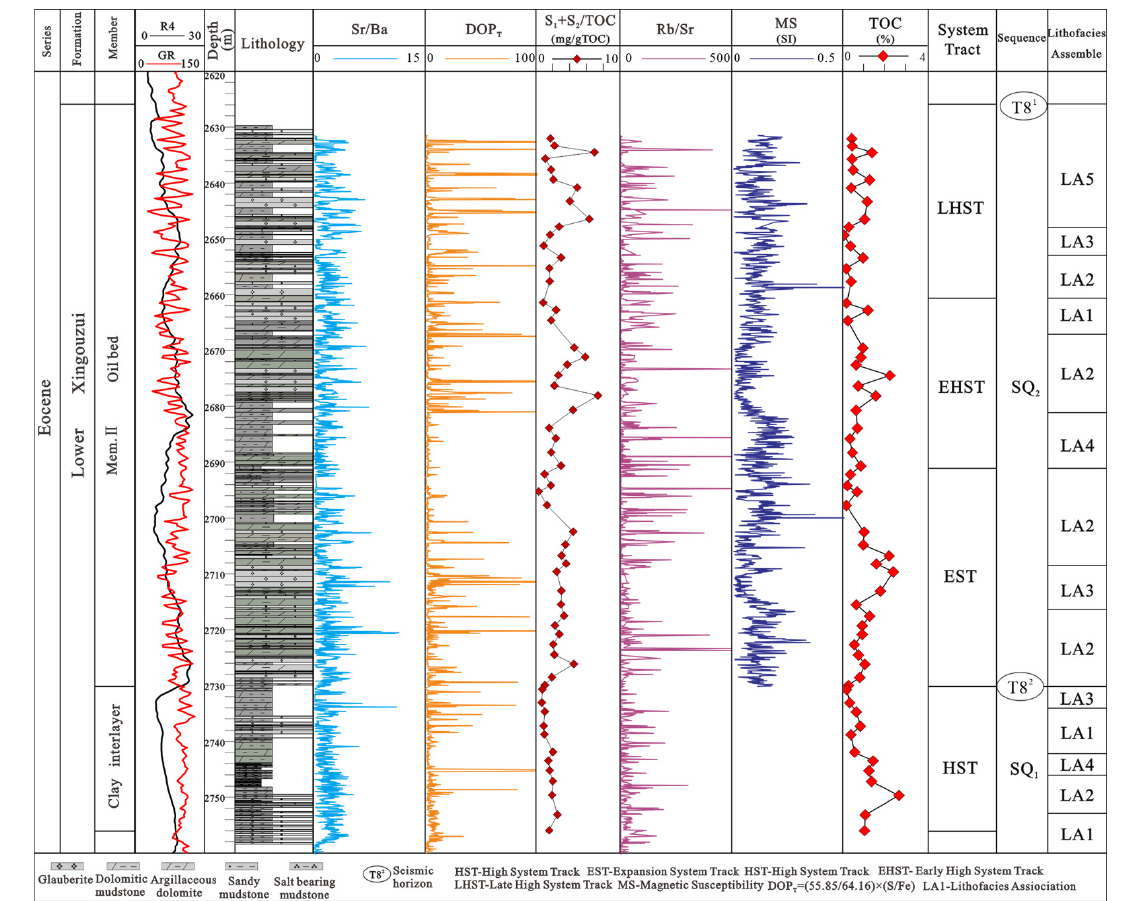
Figure 11. Geochemical parameters of lower member of Xingouzui Formation.